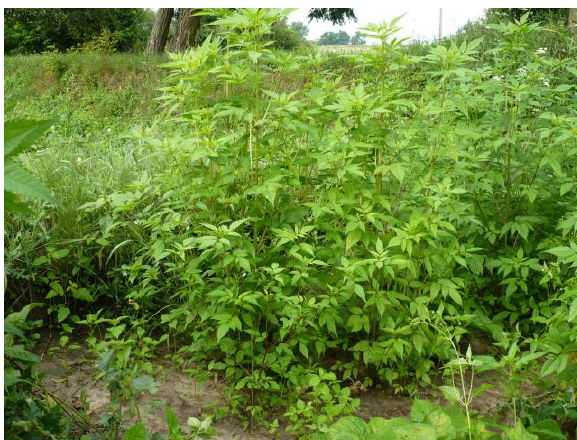
Fig. 9. Bidentetum cernuae near the village of Synevyrska Polyana, Khust district, Zakarpattia region (31.08.2019) (Photo by M. Shevera)